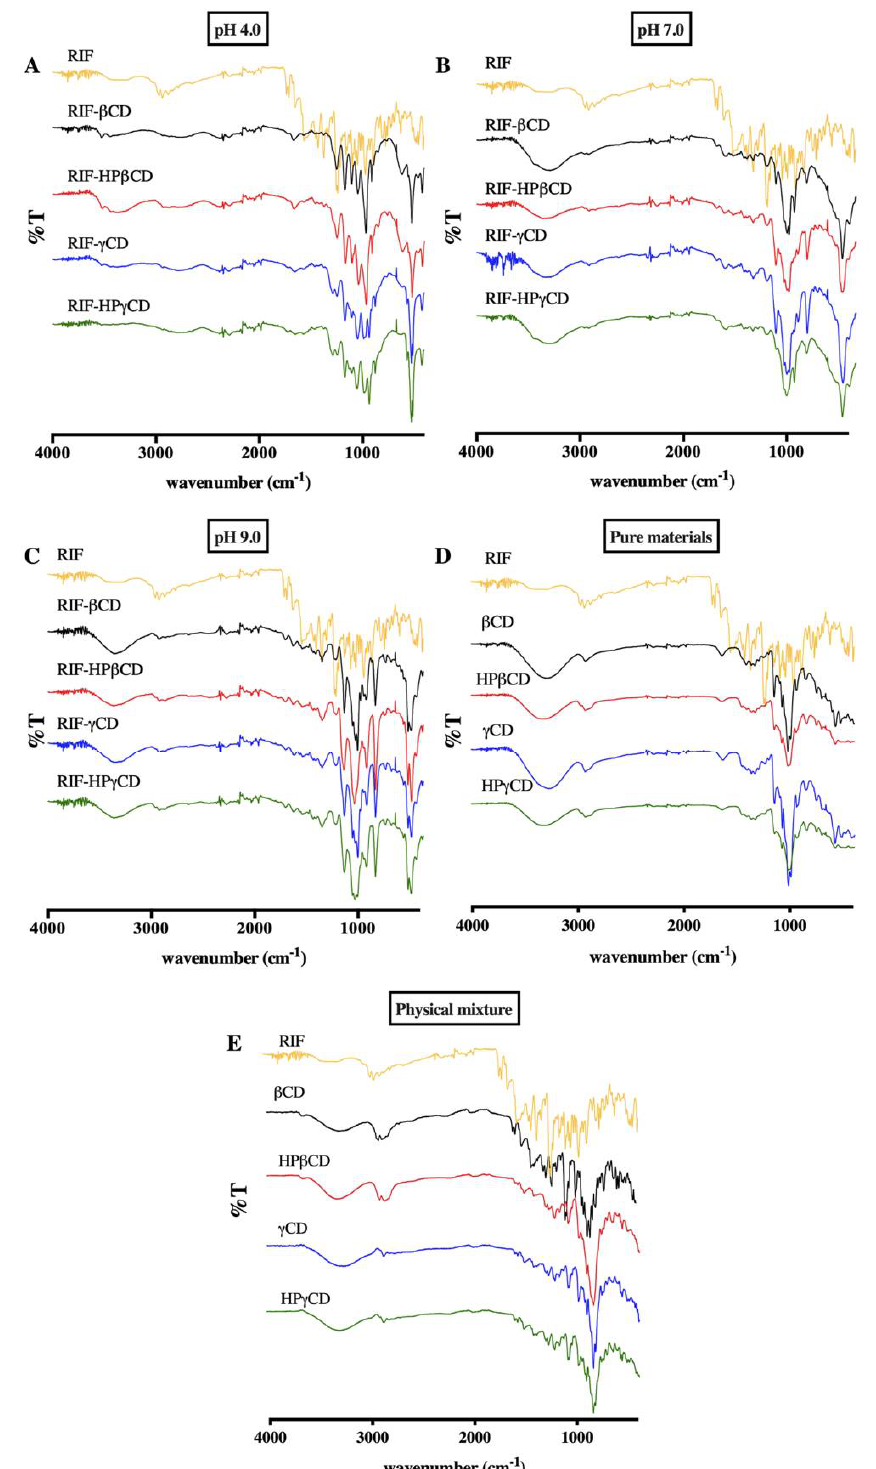
Figure 8. Representative FTIR spectra of RIF and several types of CD at ( A ) pH 4.0, ( B ) pH 7.0, and ( C ) pH 9.0. ( D ) The IR spectra of pure RIF, pure CD, and ( E ) physical mixture of RIF and CD.